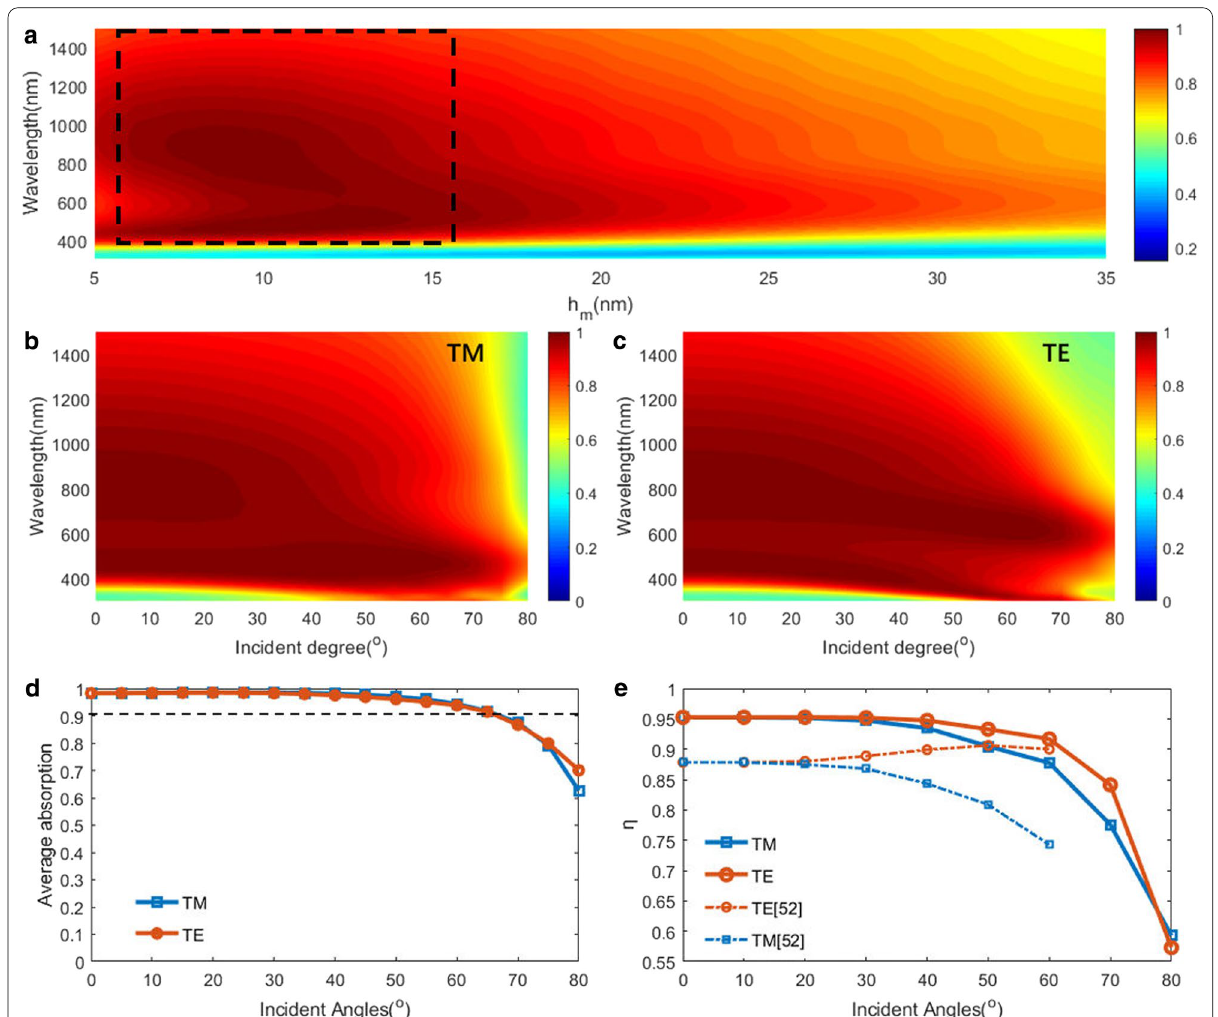
Fig. 3 a Simulated absorption spectra of the metasurface structure with different h m . b – c Angle-dependent absorption spectra of the metasurface absorber under b TE-polarized and c TM-polarized lights, respectively. d Averaged absorbance ranging from 350 to 1000 nm at various incident angles from 0° to 80° of TE-polarized and TM-polarized lights. e Calculated solar-to-thermal efficiencies ( C to 80°of TE-polarized and TM-polarized